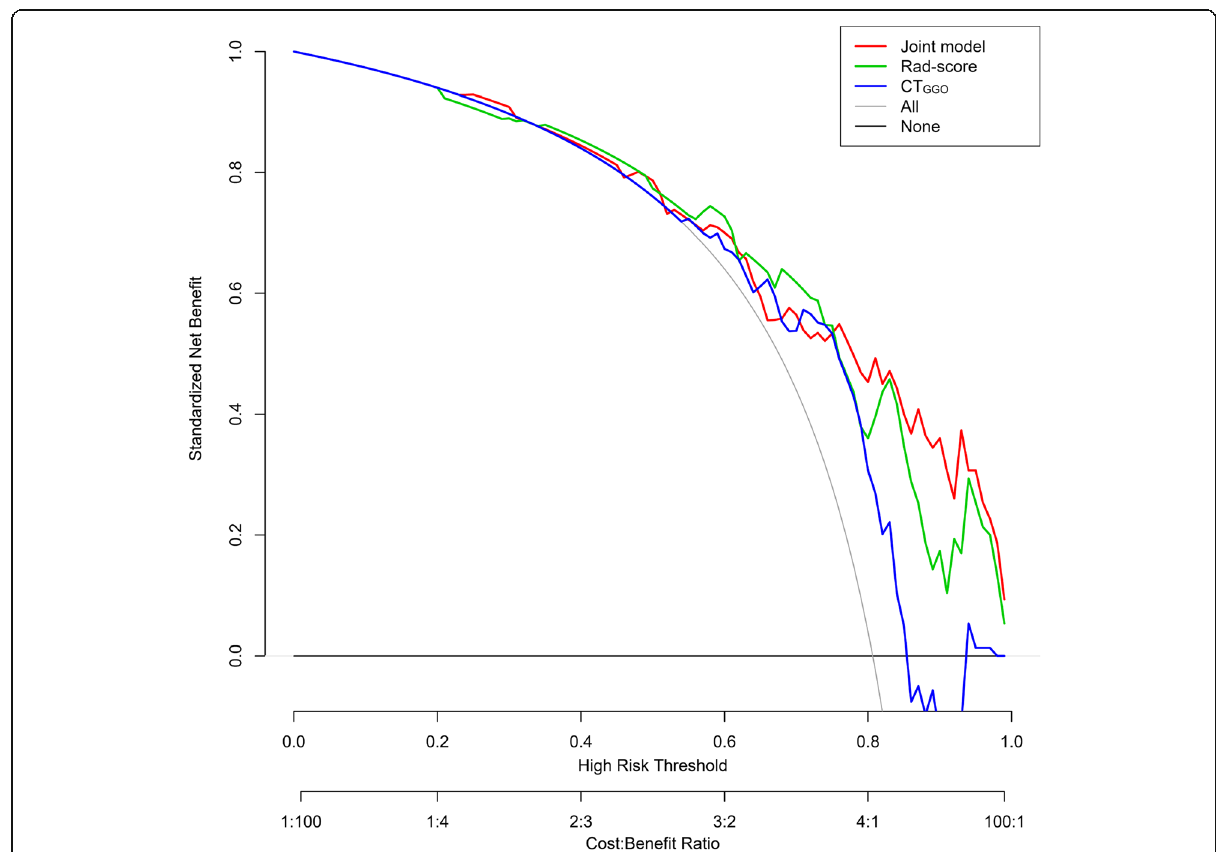
Fig. 6 Decision curve analysis of three models in predicting the correct diagnosis of intermediate-high risk growth patterns of IAC. Rad-score, radiomics signature score; CT GGO , attenuation value of the GGO component on